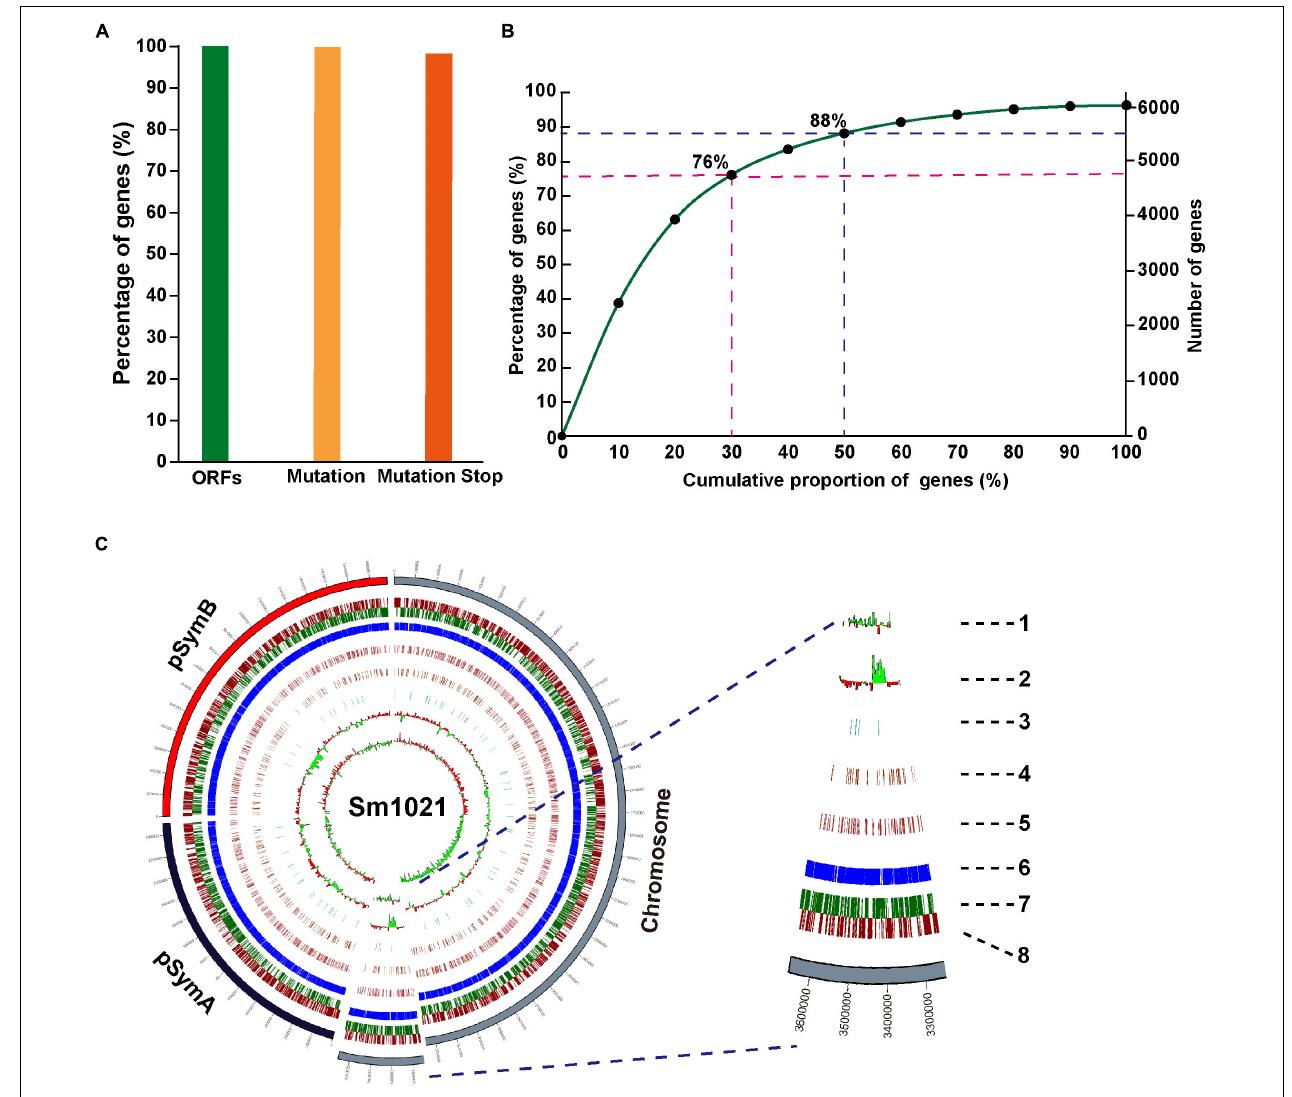
FIGURE 5 | Whole-genome prediction of target loci in S. meliloti . (A) Proportion of genes containing predicted editable sites for CBE systems. ORFs, the complete open reading frames. Mutation, genes containing predicted editable C-to-T conversion sites located on the sense strand, and genes containing predicted editable G-to-A conversion sites located on the antisense strand. Mutation stop, C-to-T, or G-to-A conversions resulting in premature stop codons. (B) Cumulative curve for the distribution of generated premature stop codons inside gene bodies (coding region). (C) Circos plot showing the distribution of genes editable by CBE systems in the genome of S. meliloti . Concentric circles from the inside to the outside: (1) CG skew; (2) CG content; (3–5) genes with stop mutation sites in 0–30% (3), 30–50% (4), and 50–80% (5) of the gene body; (6) gene annotations; and (7–8) distribution of the genes in reverse (7) and forward (8) strands of the